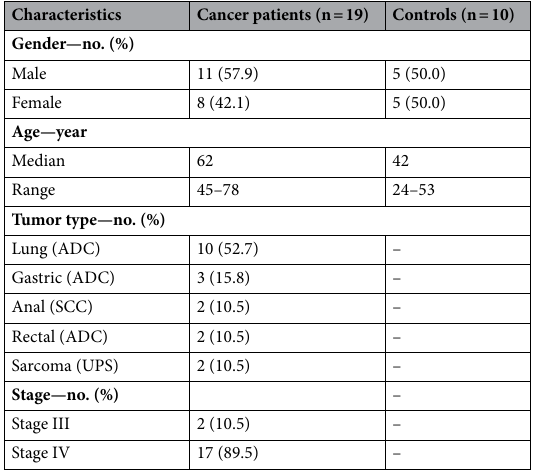
Table 1. Clinical characteristics of the cancer patients and controls included in the study. ADC, adenocarcinoma; SCC, squamous cell carcinoma; UPS, undifferentiated pleomorphic